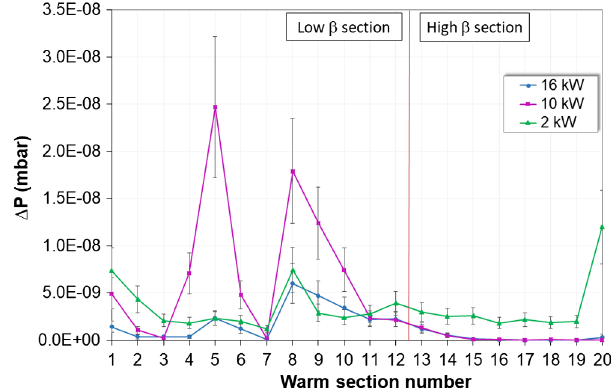
FIG. 20. Pressure variations at 16 kW (blue), 10 kW (violet), and 2 kW (green).